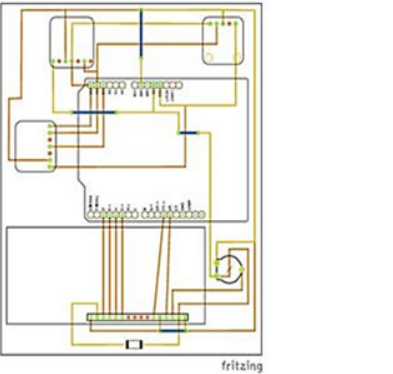
Figure 3. The circuit design and PCB diagram (made by V. V. Áron 11th grade student).